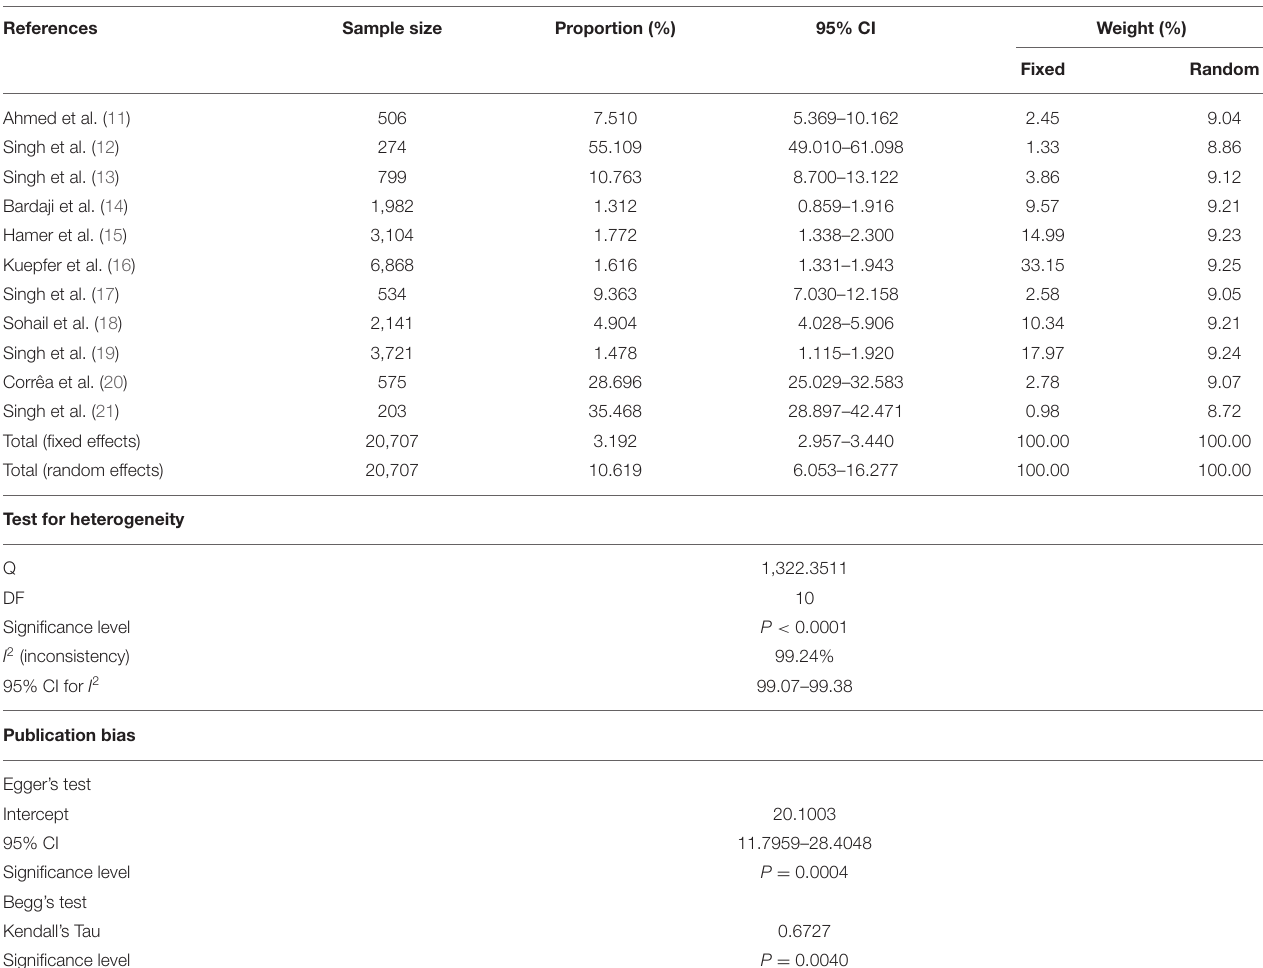
TABLE 6 | Pooled prevalence analysis of malaria in asymptomatic pregnant